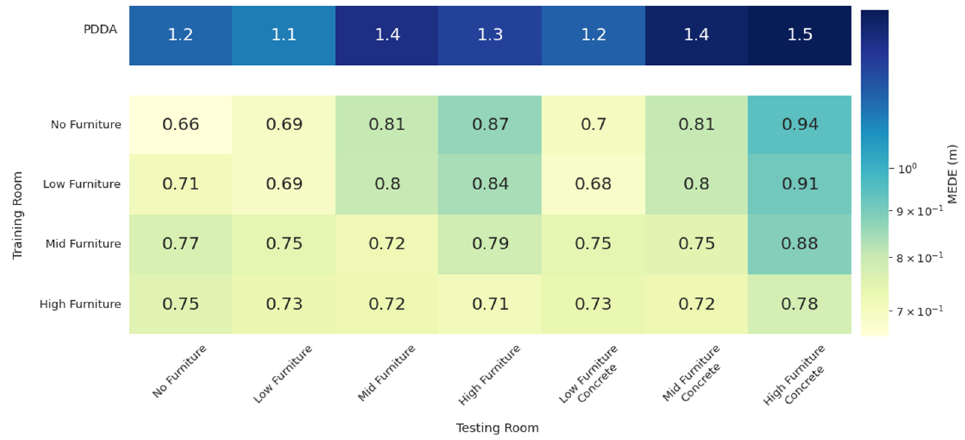
each room is included for reference.